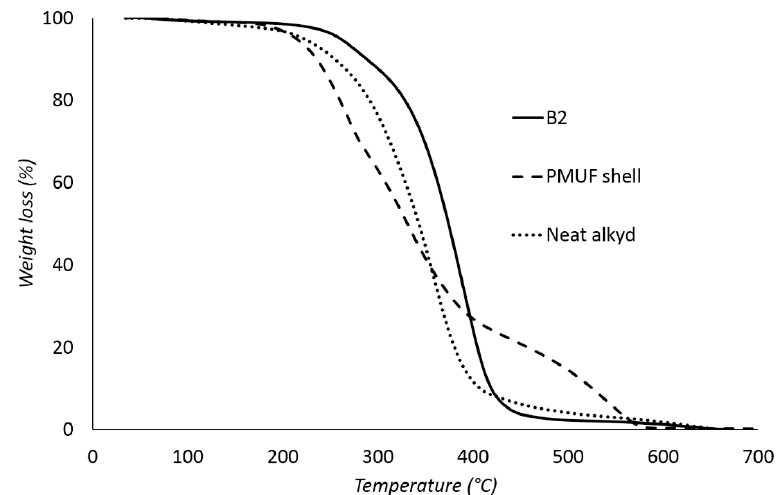
Figure 10. TGA thermograms of B2, neat alkyd and PMUF shell.